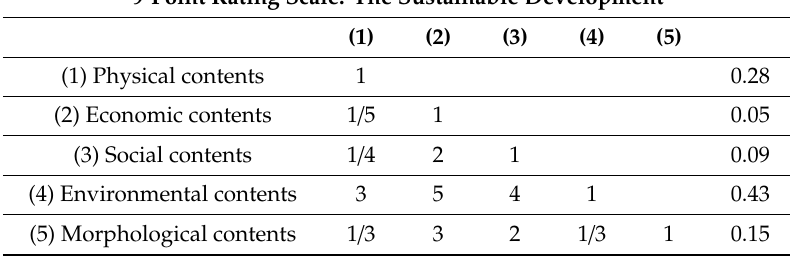
Table 4. The sustainable development criteria computation of the five sub-criteria, along with a pair-wise comparison